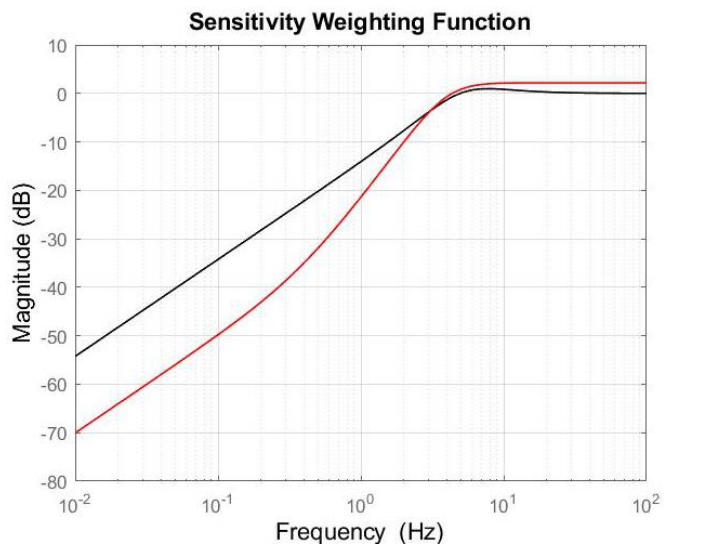
Figure 9. S ( s ) (black line) and W s ( s ) (red